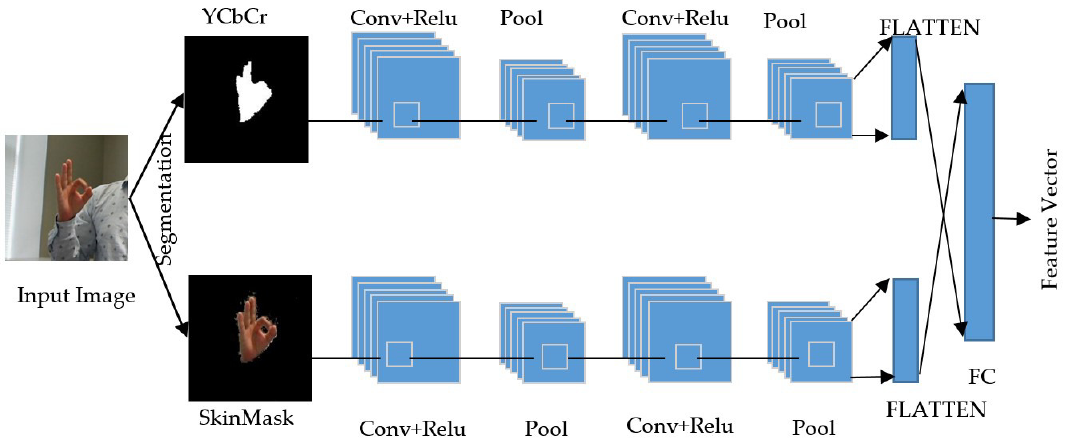
Figure 6. The architecture of the proposed feature extraction